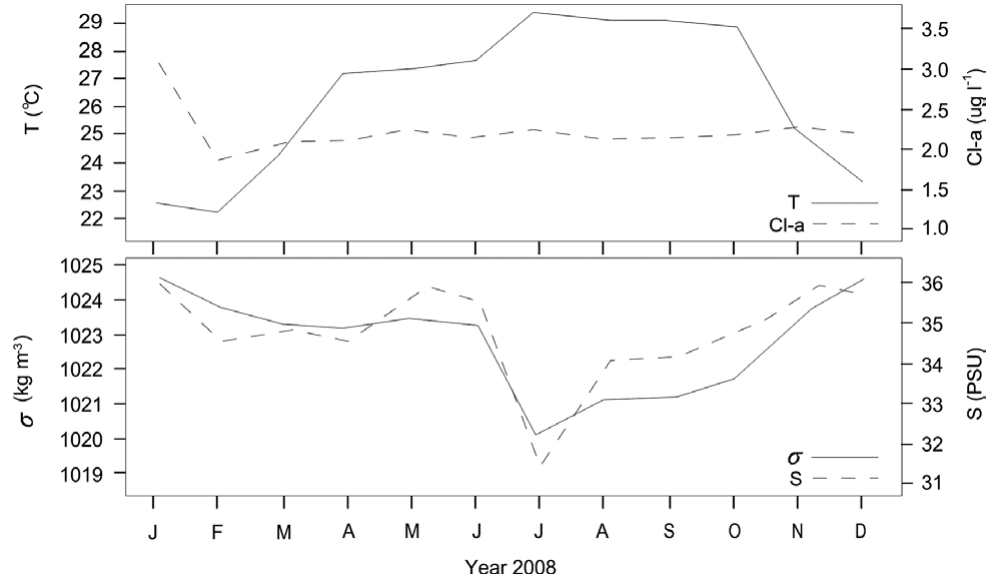
Fig. 6. – Yearlong temperature, chlorophyll-a levels, density and salinity from January to 10 December